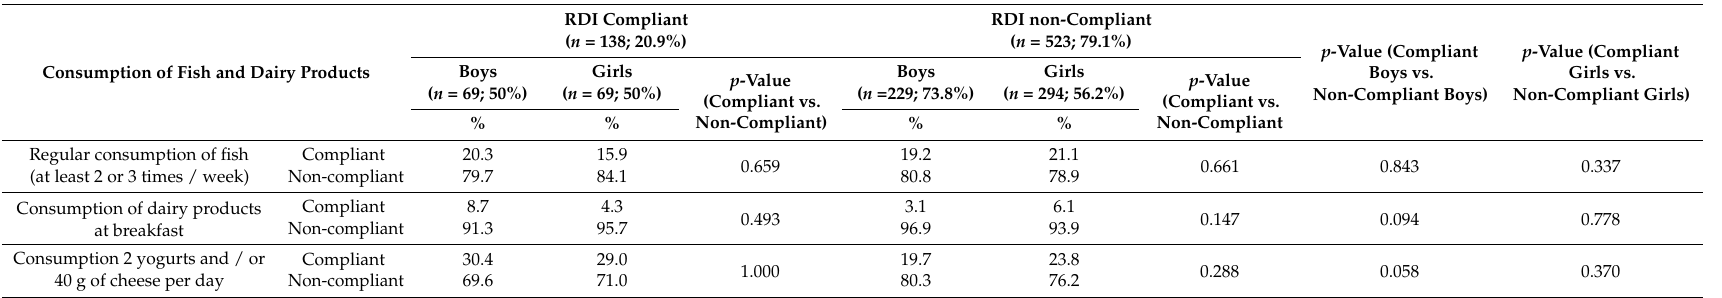
Table 3. Consumption of fish and dairy products of the sample studied by gender and with respect to the suitability of the iodine RDI. RDI Compliant ( n = 138; Consumption of Fish and Dairy Products